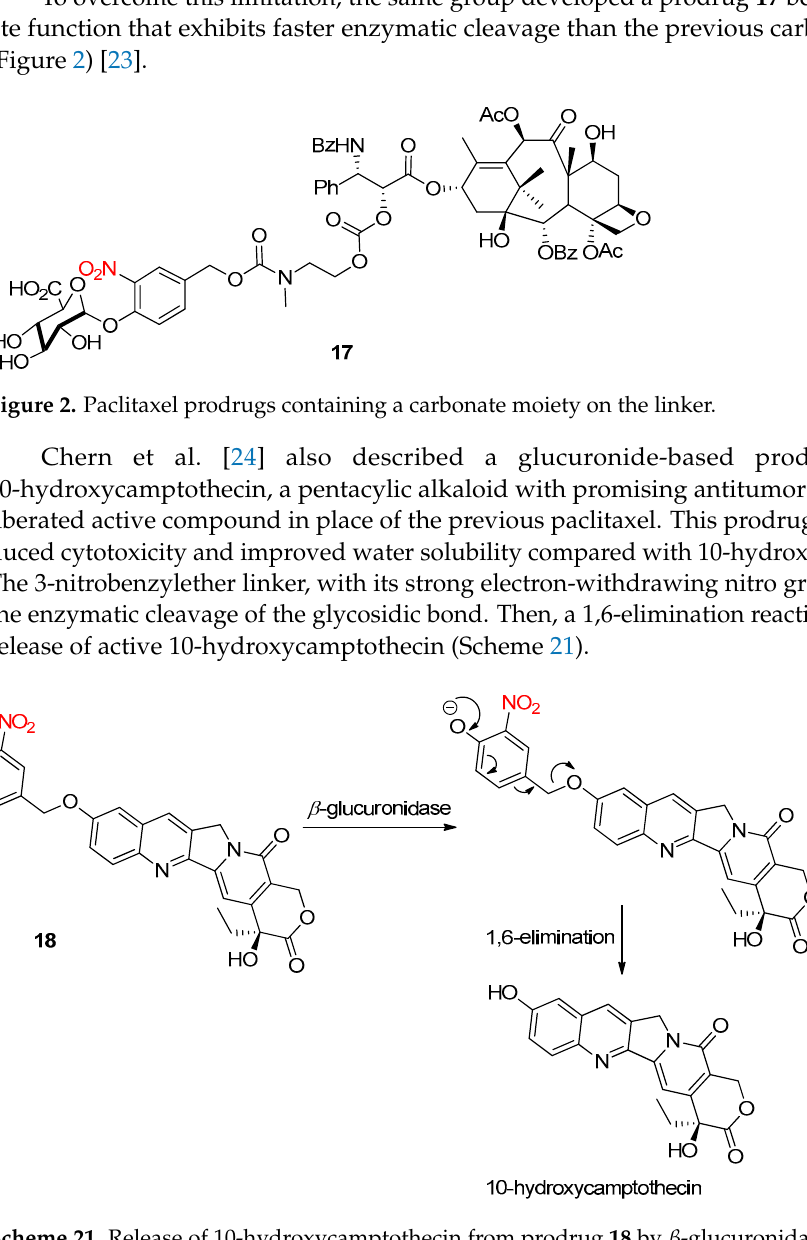
Scheme 21. Release of 10-hydroxycamptothecin from prodrug 18 by β -glucuronidase activation.